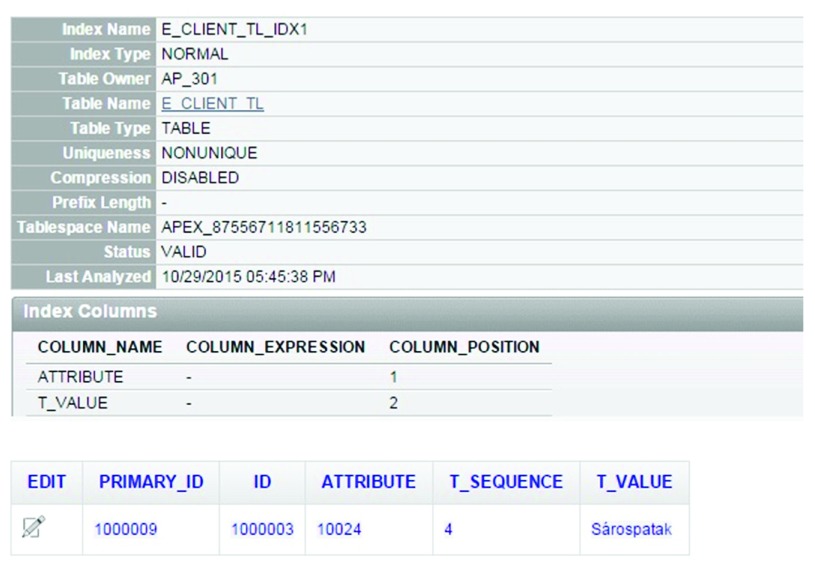
Indexing a record.